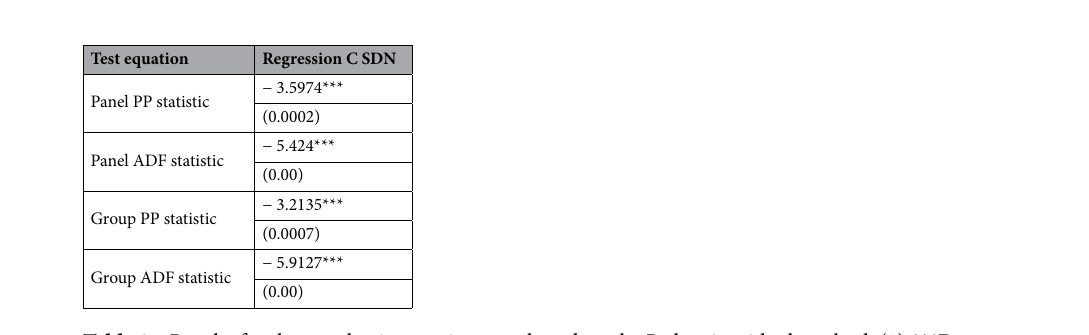
Table 3. Results for the panel cointegration tests based on the Pedroni residual method. (1) ***Denote significance at the 1% level. (2) The values in parentheses are the p-values. (3) SDN denotes the sum of digital number.